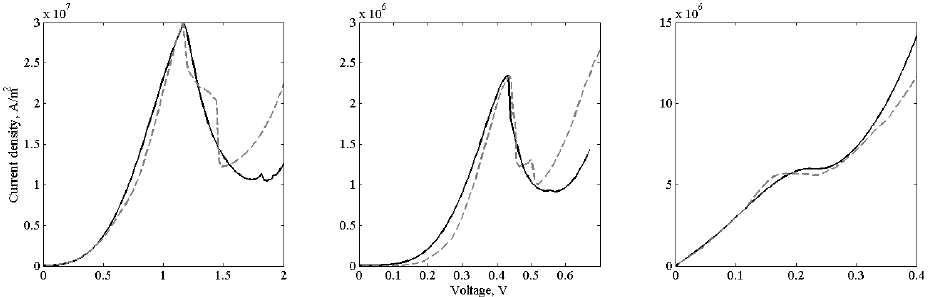
Fig. 2. The calculation results (black line) in comparison with the experiment (grey dotted